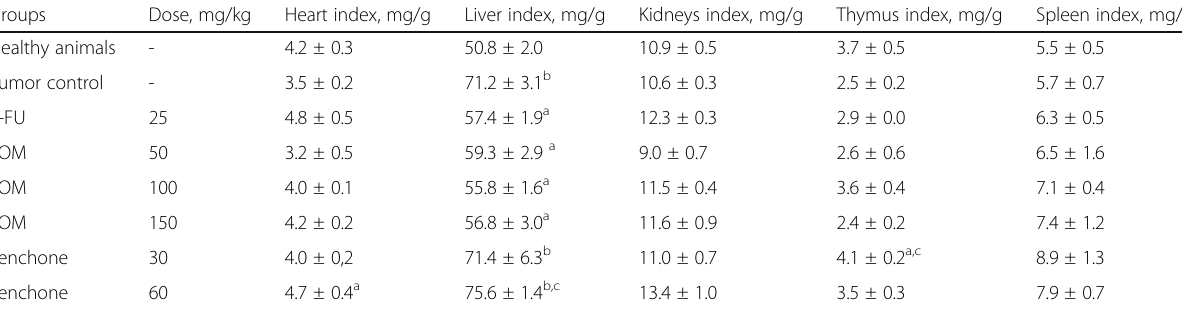
Table 6 Effects of EOM, fenchone and 5-FU in the mice organ indices ( n =6) subjected to different treatments (9 days) Groups